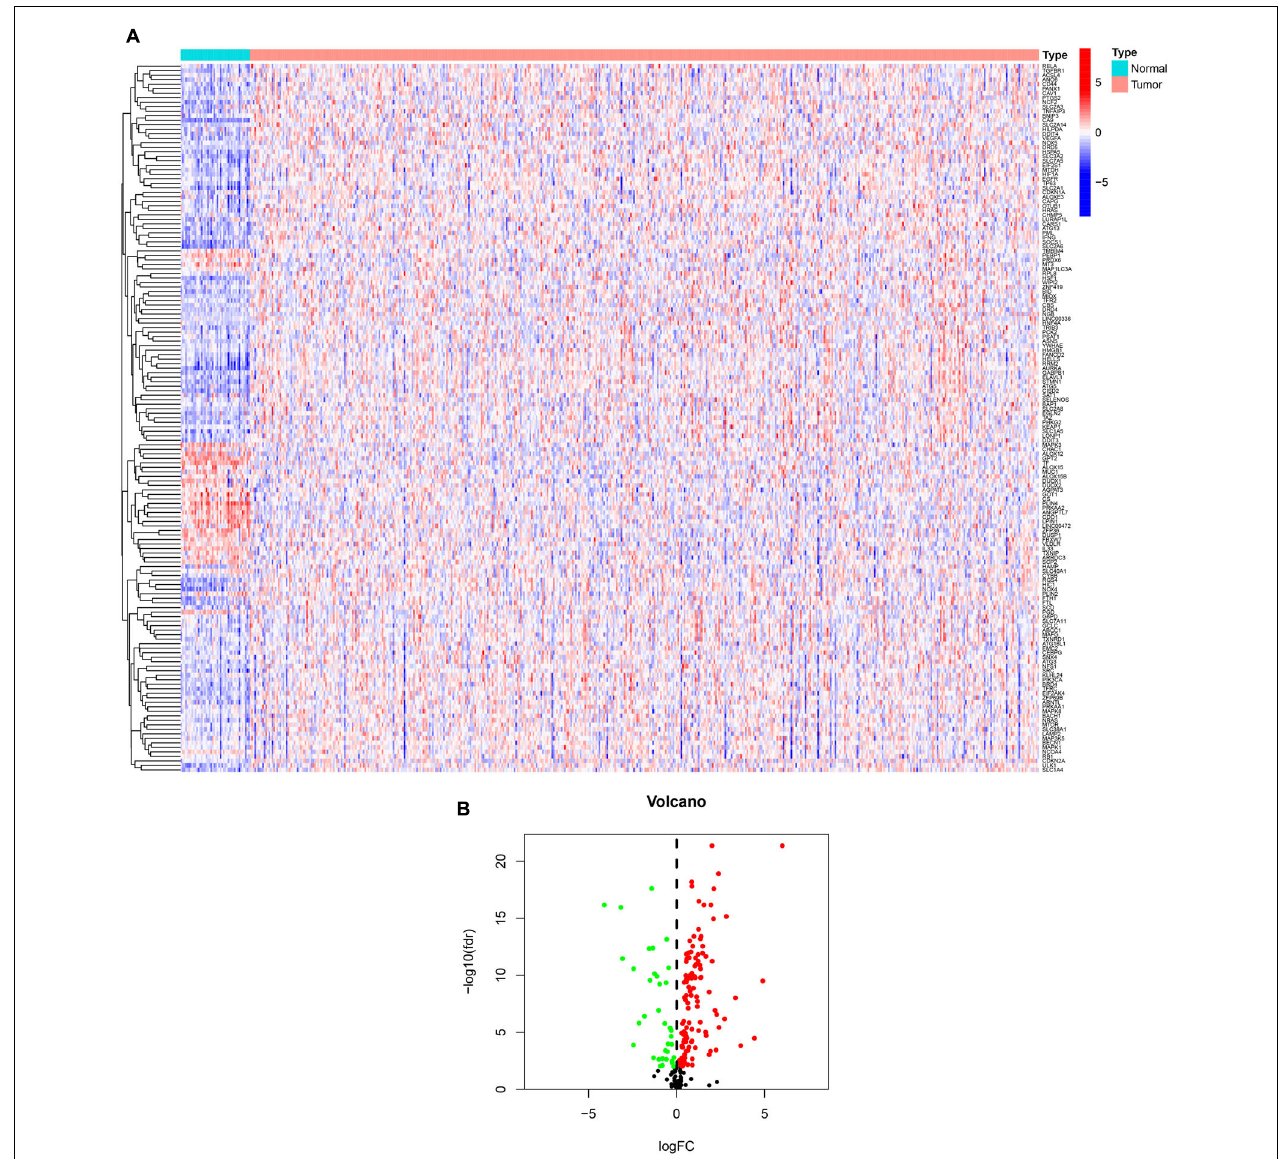
FIGURE 2 | Overview of DE-FRGs. (A) The heat map shows the expression profile of DE-FRGs. (B) The volcano chart shows the regulation profile of DE-FRG. Red dots represent upregulated genes, while green dots represent downregulated genes.